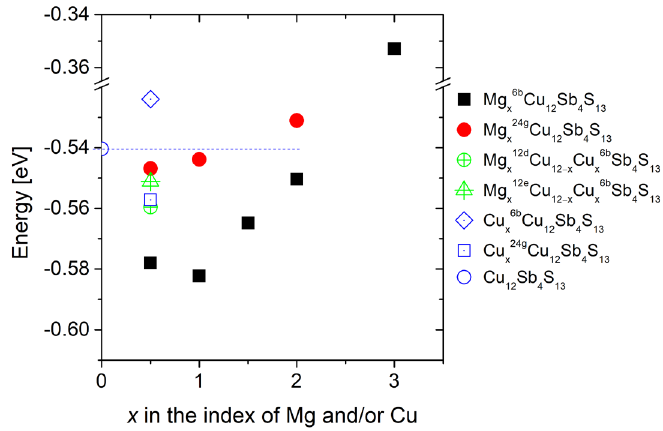
Figure 2. Calculated energy of formation of Mg x Cu 12 Sb 4 S 13 and Cu 12+x Sb 4 S 13 . Dashed line indicates energy for pure tetrahedrite. The upper indexes indicate the position of the atom in the structure for which calculations were carried out. If not indicated, Cu, Sb and S occupy their nominal positions, i.e., 12d/12e, 8c, 24g/2a, respectively.